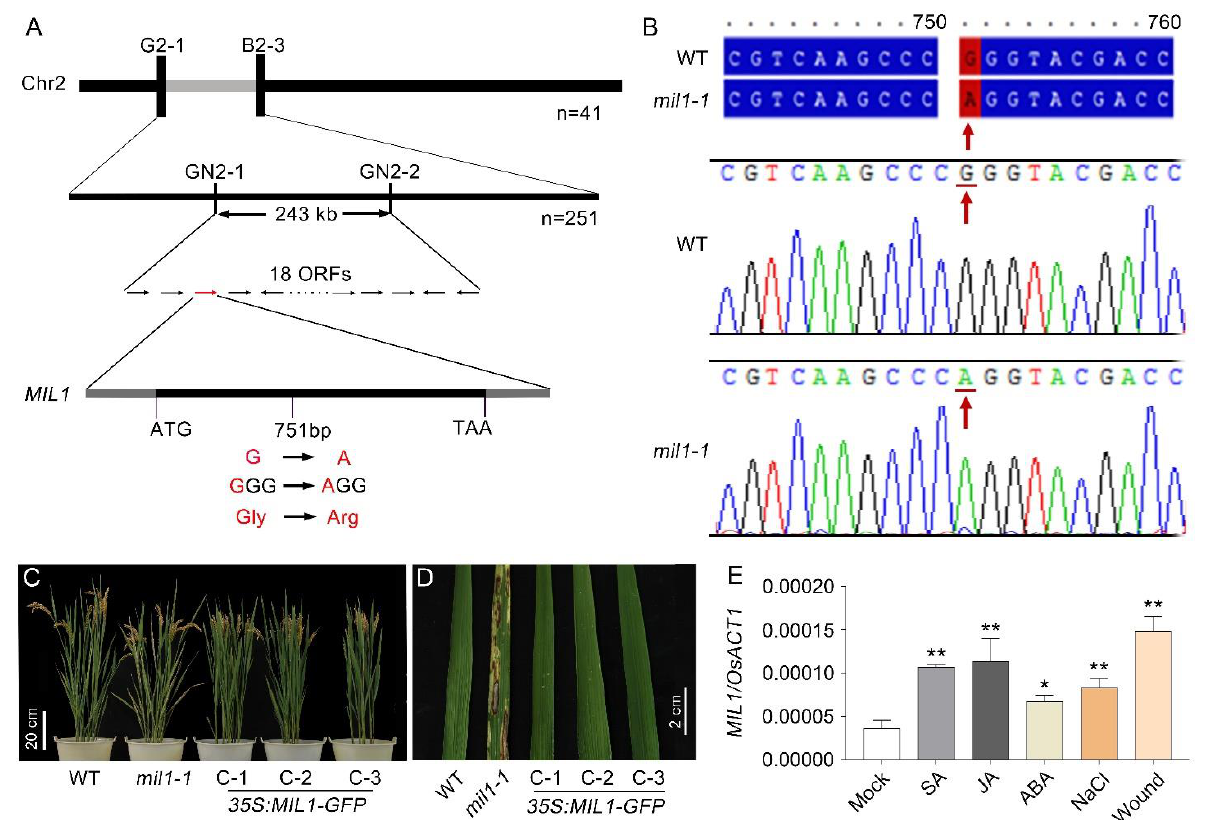
Figure 6. Positional cloning of mil1-1 mutation and complementary test. ( A ) Map-based cloning of MIL1. Number under the horizontal chromosome bars transverse are recombinants and predicated 18 ORFs in the 243 kb region flanking by GN2-1 and GN2-2 markers. ( B ) Sequence alignment and the trace file of the mutation identified by sequencing in mil1-1 . ( C ) Photos of WT, mil1-1 and three complementary transgenic lines. Scale bar is 20 cm. ( D ) Leave comparison of WT, mil1-1 and three complementary transgenic lines. Scale bar is 2 cm. ( E ) Expression of MIL1 / OsHPL3 detected by RT-qPCR in WT plants in different treatments. Rice ACTIN 1 ( OsACT1 ) was used as an internal control. Data in ( E ) are means ± SD. Asterisks indicate significant differences between treatments and respective controls at each time point (* p < 0.05, ** p < 0.01; Student’s t test).